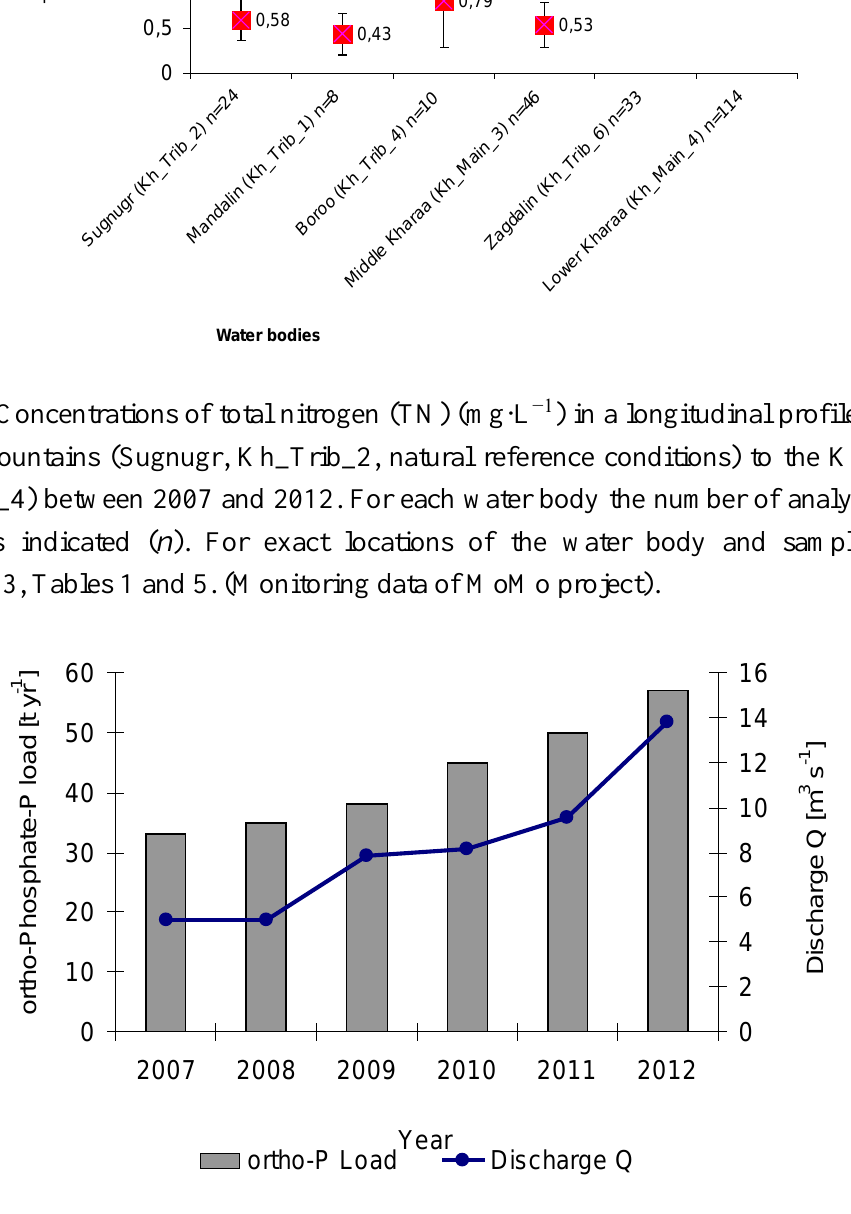
Figure 8. Loads of ortho-phosphate (t·yr −1 ) at the KRB outlet (Lower Kharaa, Kh_Main_4, Sel_Kh10_001) for the monitoring period 2007 to 2012. The exact location of the water body and monitoring site Buren Tolgoi is given in Figure 3, Tables 1 and 5. (Monitoring data of MoMo